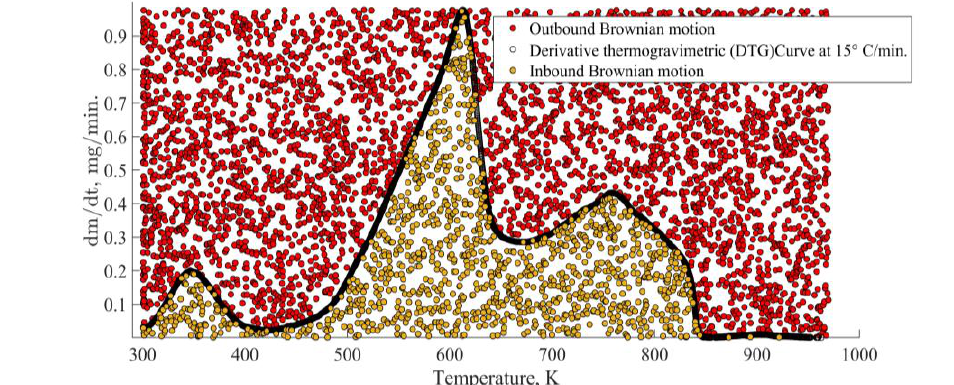
Fig. 3. Brownian motion of inbound and out bound particles on the DTG plane at